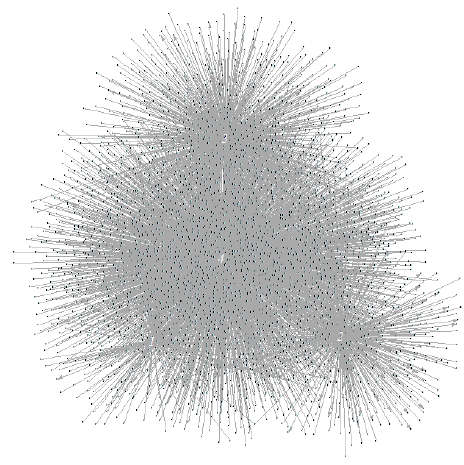
Figure 5. Interbank network out-degree distribution.